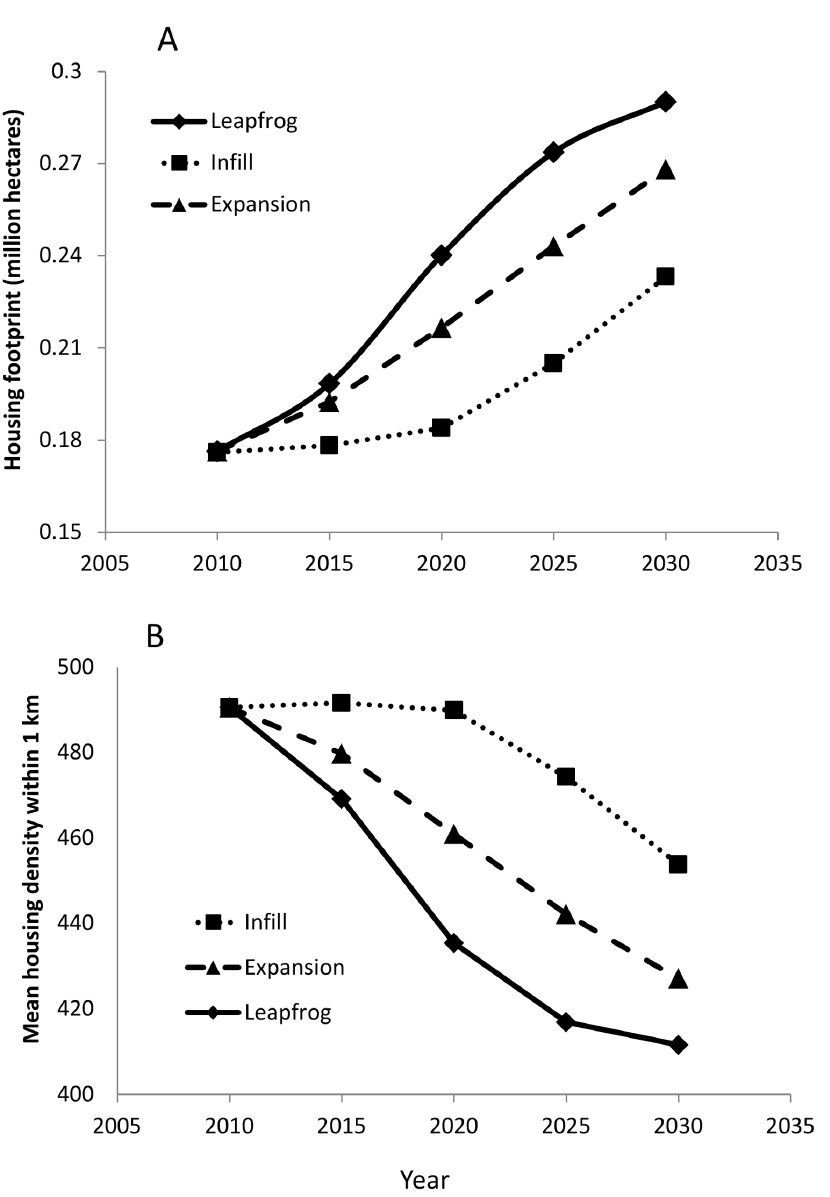
Figure 1. Trends of development extent and pattern for three planning policy simulations from 2010–2030, including A) total housing footprint representing the area of land within all housing clusters, and B) mean housing density averaged across all housing clusters.